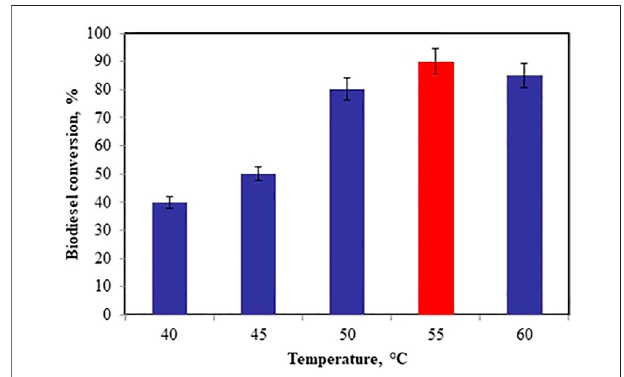
FIGURE 6 | Effect of co-catalyst concentration on biodiesel production. FIGURE 7 | Effect of reaction temperature on biodiesel